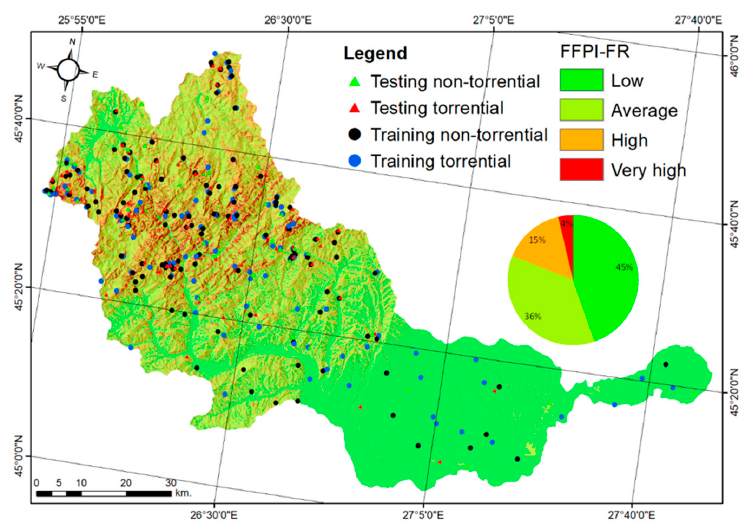
Figure 7. Flash ‐ Flood Potential Index (FFPI)–FR spatial distribution.